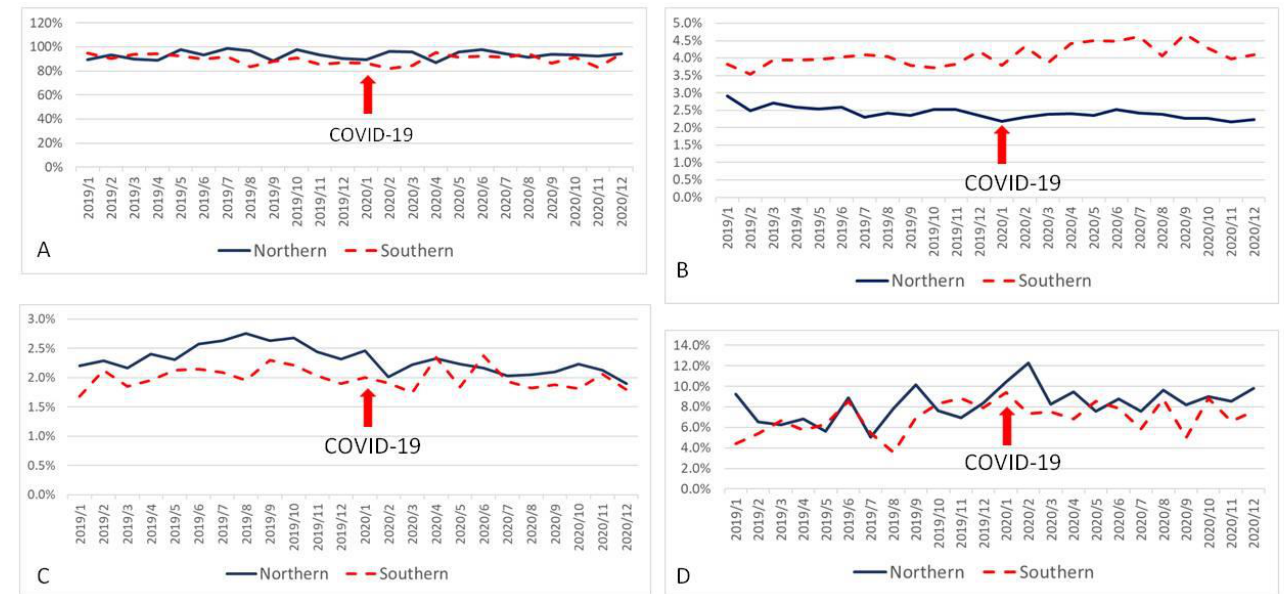
Figure 1. Control chart of emergency room-related quality indicators based on the location of medical centers (red arrow represents outbreak of COVID-19). ( A ): Proportion of STEMI patients receiving PPCI within 90 min after arrival at the emergency room. ( B ): Proportion of patients leaving the emergency room without complete treatment. ( C ): Unscheduled returns within 72 h for emergency patients. ( D ): Proportion of acute ischemic stroke patients receiving IV-tPA.